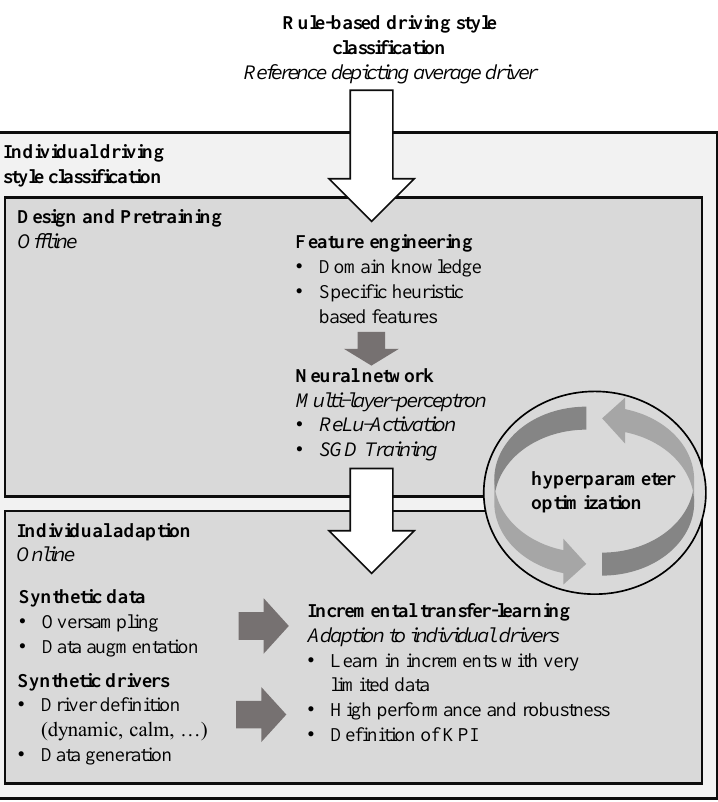
Figure 1. Architecture of the individual driving style classification